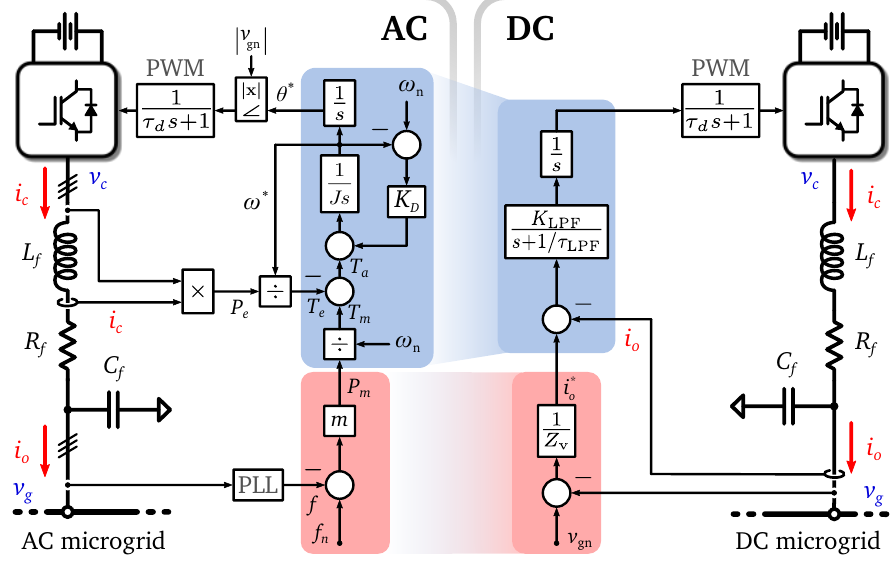
Figure 6. Proposed virtual-impedance-based primary control strategy for DC microgrids.